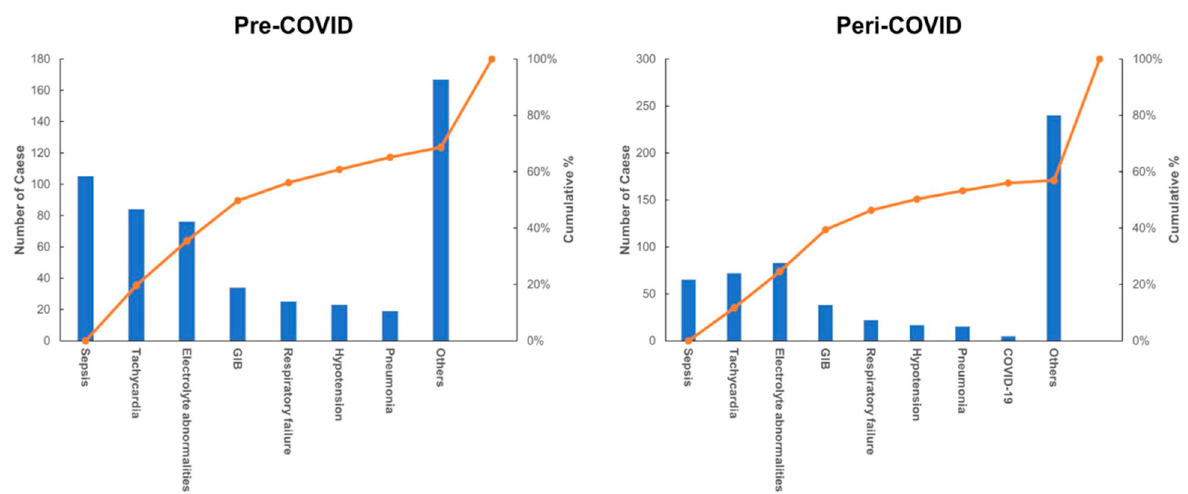
Figure 1. A Pareto chart depicting the major reasons for inappropriate telemetry ordering during the pre-COVID-19 and the peri-COVID-19 periods.